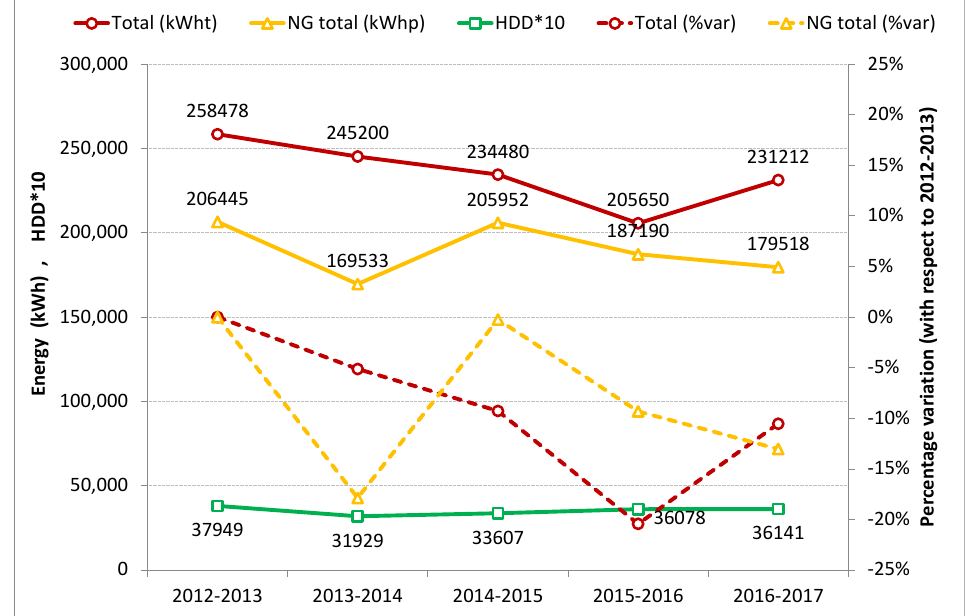
Figure 11. Seasonal total thermal energy need (in thermal kWh), NG consumption (in primary energy kWh), and heating degree days (HDD). The percentage variations with respect to the first heating season are reported as well.